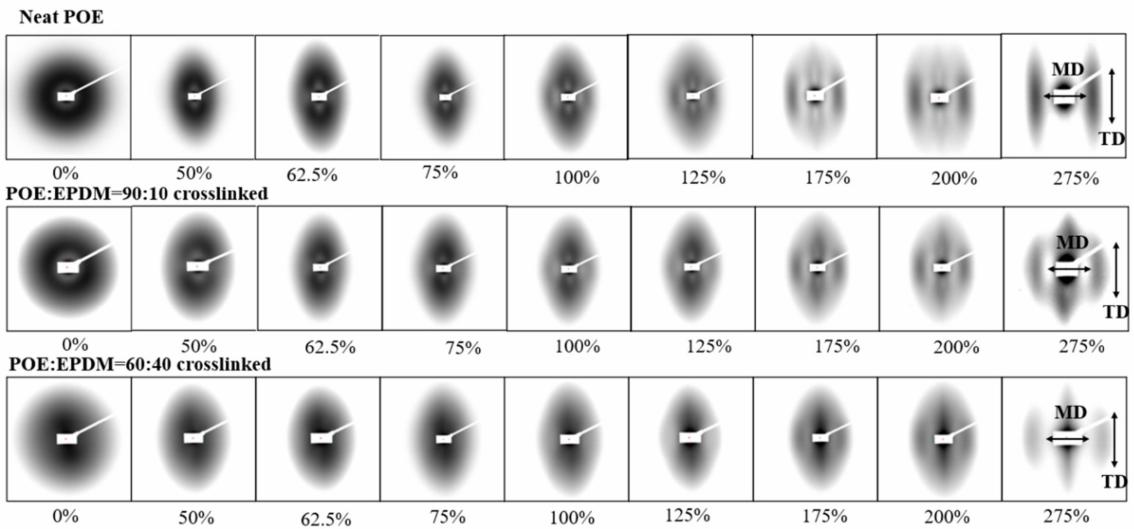
Figure 5. The 2D SAXS patterns of the dynamic crosslinked blends (POE:EPDM = 90:10 and POE:EPDM = 60:40) and neat